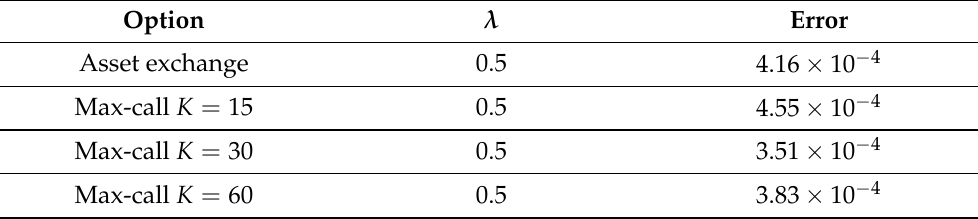
Table 6. Error according to the loss weight